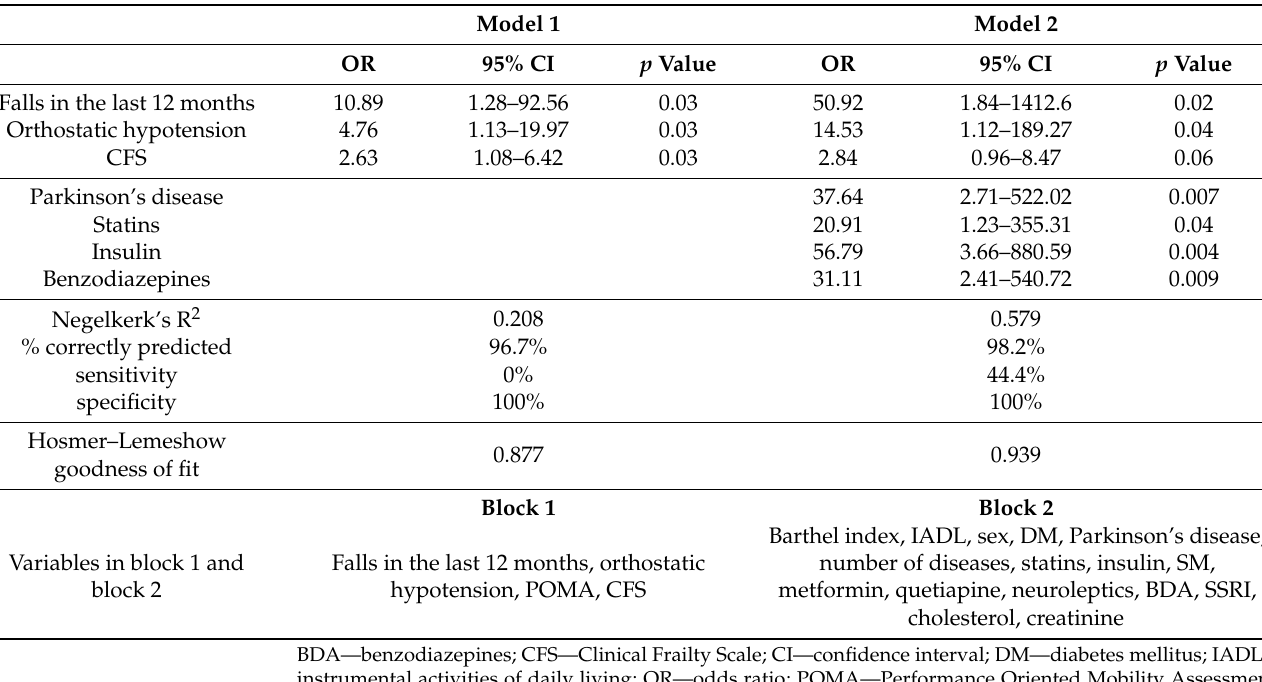
Table 5. Predictors of falls—backward multivariable logistic regression